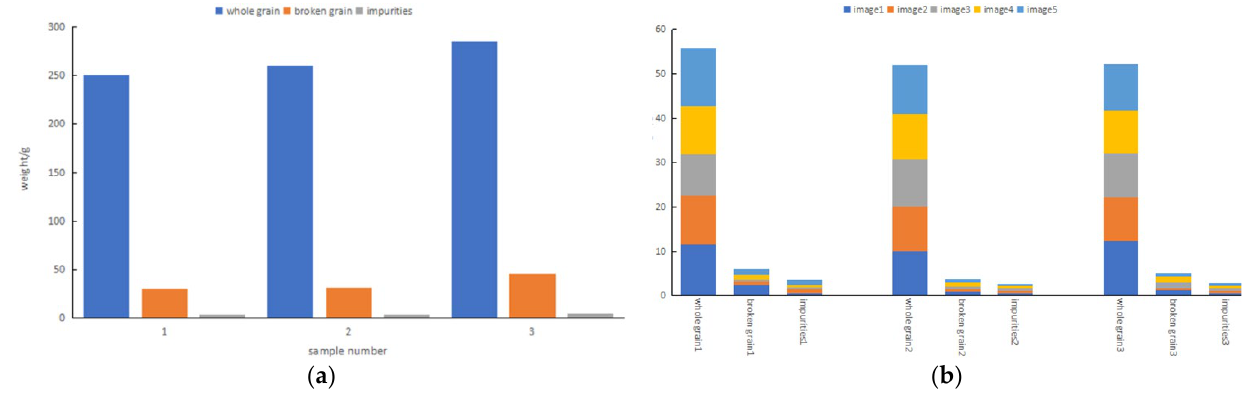
Figure 12. Histograms of mass test results of various substances such as corn grains. ( a ) Manual test data results. ( b ) Machine inspection data results. Table 7. Test results of impurity content and breakage rate.